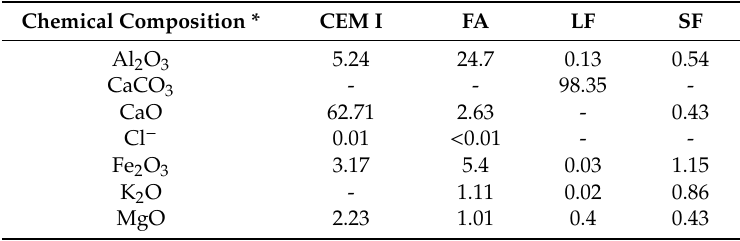
Table 1. Chemical composition and grading of the raw materials